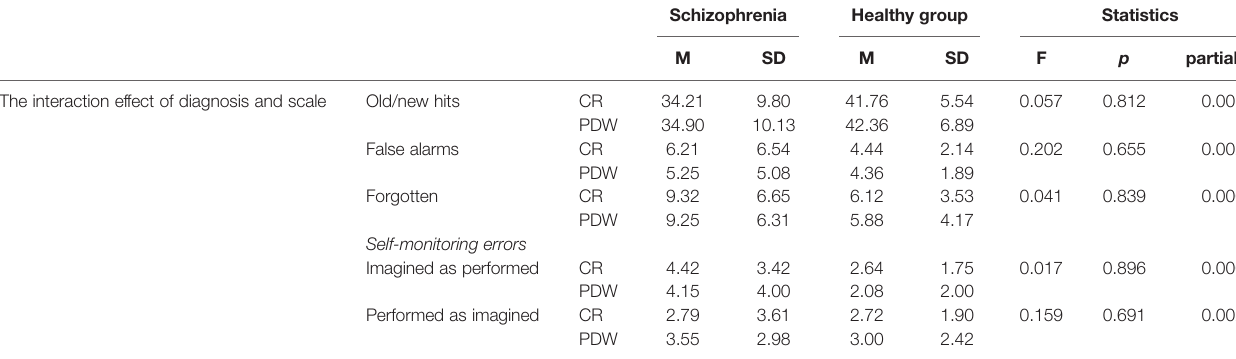
TABLE 5 | The interaction effect of type of scale (CR vs. PDW) and diagnosis (patients with schizophrenia vs. healthy controls) on performance.